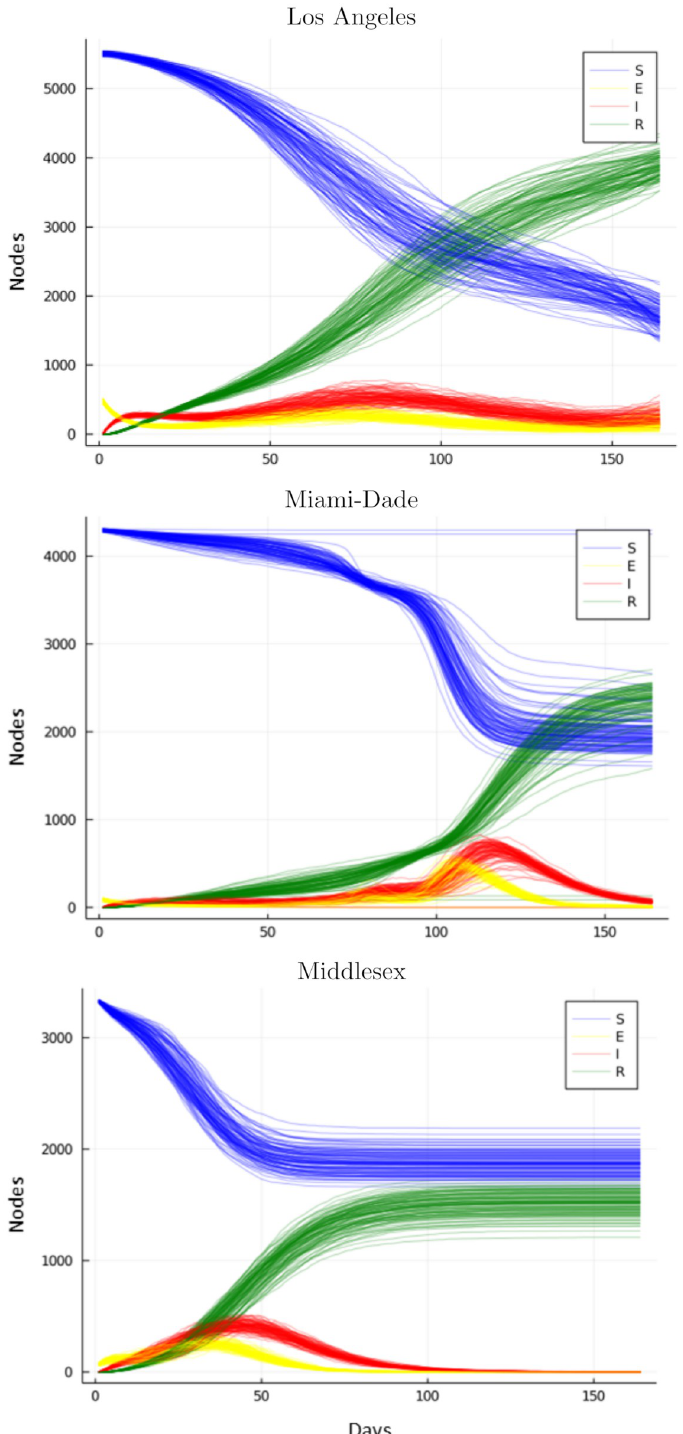
Fig 10. SEIR curves produced by fitted model. Our method is capable of fitting different disease dynamics in different regions including infections with multiple waves and different rates of infectivity over time. We plot the total Susceptible, Exposed, Infected, and Removed (SEIR) counts over 160 days from 100 simulations for our fit posterior distribution.